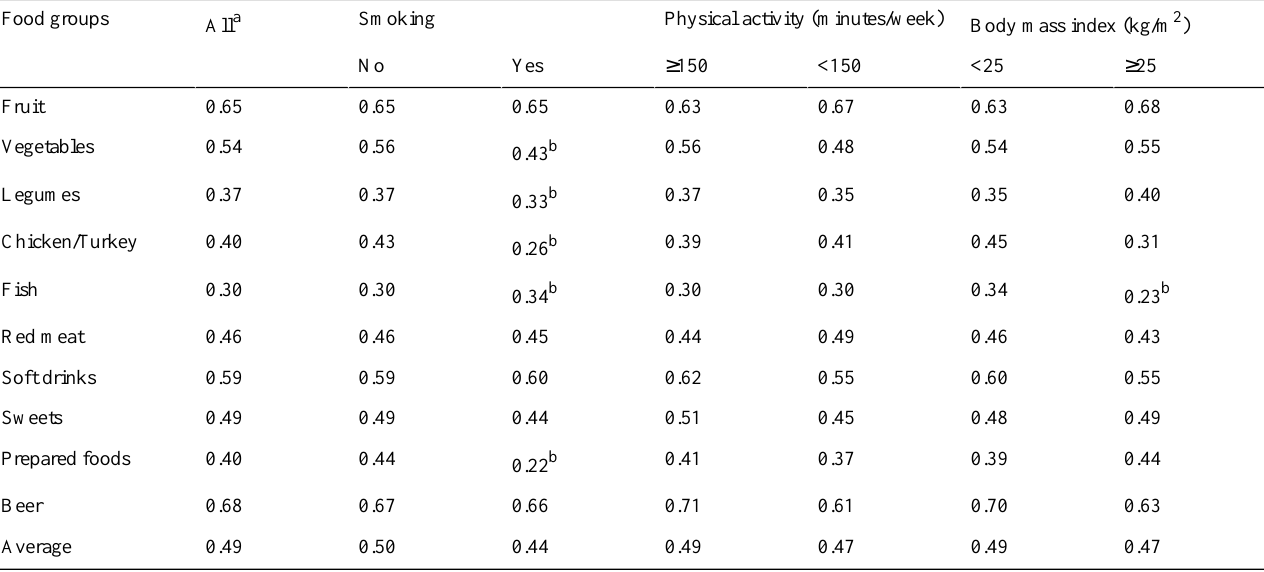
Table 7. Weighted kappa derived from the electronic 12-hour dietary recall app versus the food frequency questionnaire for categories of food group consumption and strata: smoking: no and yes; physical activity (minutes/week): ≥ 150 and <150; and body mass index (kg/m 2 ): <25 and ≥ 25. Comparison of the electronic 12-hour dietary recall app versus the food frequency questionnaire.